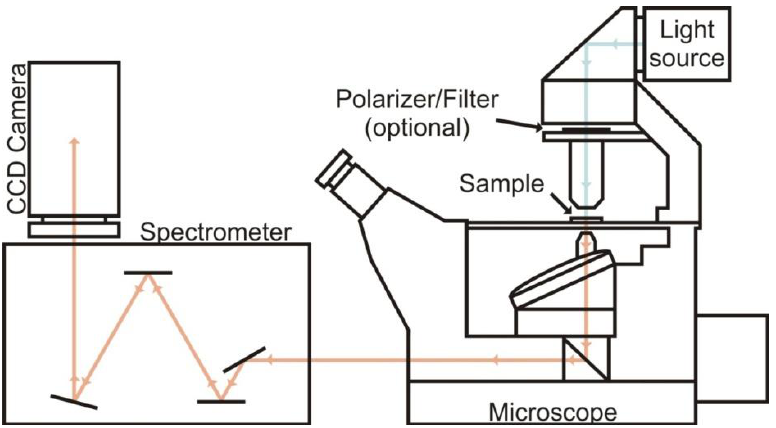
Figure A6. optical measurement setup in transmission mode. Light is guided through a nanowire array into a spectrometer. Finally, the transmitted spectral intensity is recorded by a CCD